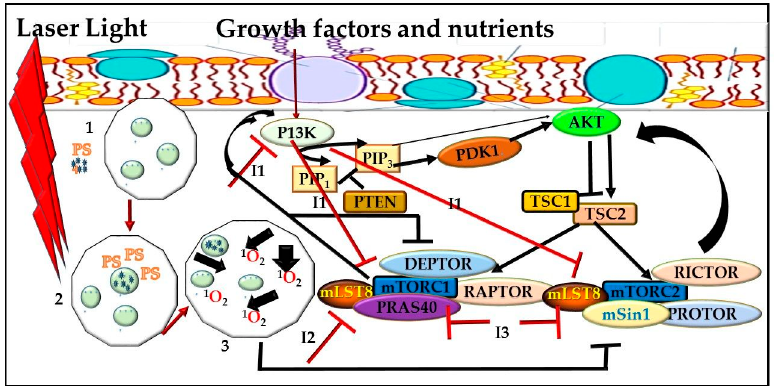
Figure 3. Proposed mechanism between mTOR Signaling Pathway, Inhibitors and Photodynamic Therapy (PDT). PDT down-regulates AKT-mTOR pathway because of reactive oxygen species (ROS) production. 1. Photosensitizer is injected into a targeted tumor. 2. Laser light is emitted at a particular wavelength. 3. Cells become activated and release reactive oxygen species, which results to tissue destruction and cell death. Interaction with inhibitors phosphoinositide 3-kinase (I1), rapamycin (I2) and mTOR kinase (I3) to enhance cell death through the P13K/AKT-mTOR pathway.